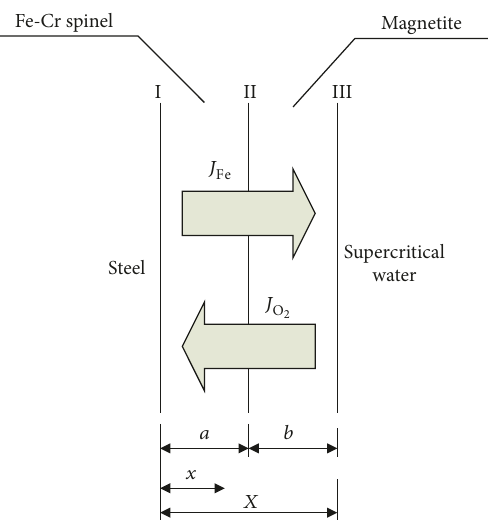
Figure 1: Schematic illustration of diffusion of oxygen and iron in the duplex scale in the magnetite and Fe-Cr spinel formation